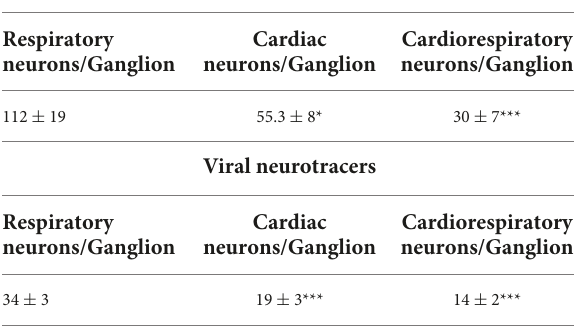
TABLE 1 Quantification of cardiac, respiratory, and dual labeled cardiorespiratory neurons on confocal imaging in the mouse NJG